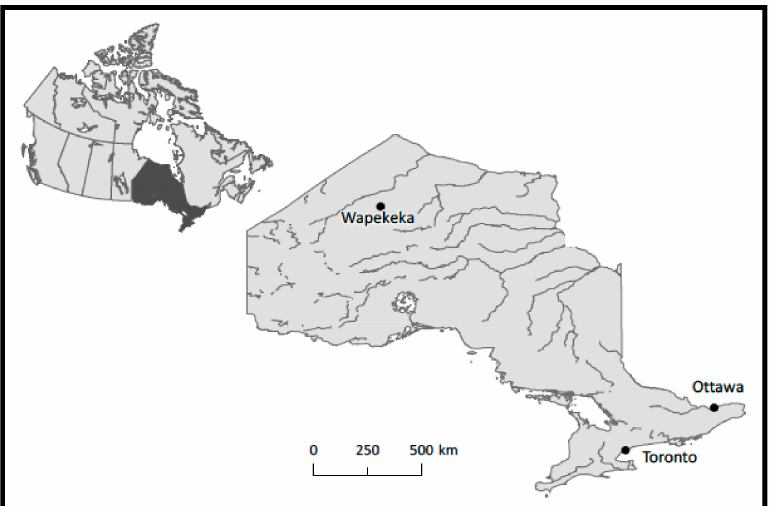
Figure 1. Map identifying the location of the First Nation community of Wapekeka in northern Ontario, Canada. Map created by Sarah Simpkin, University of Ottawa Library, on 1 November 2018 using Natural Earth data in ArcGIS